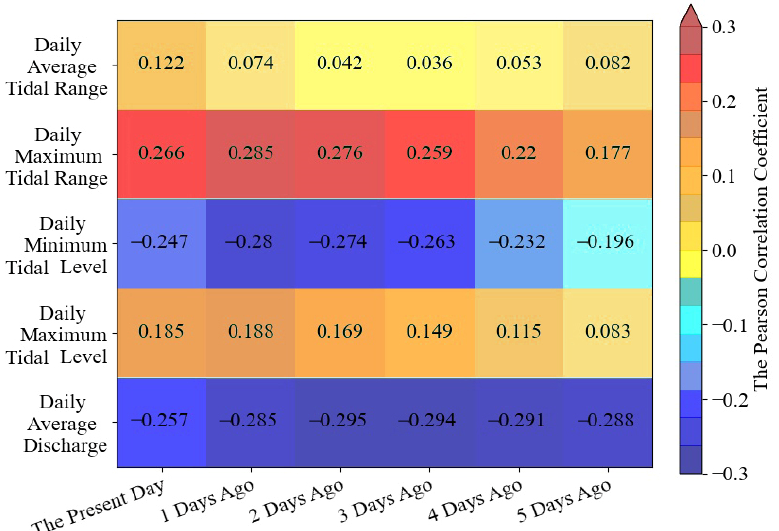
Figure 4. Pearson correlation coe ffi cients between in fl uence factors and chlorine level.